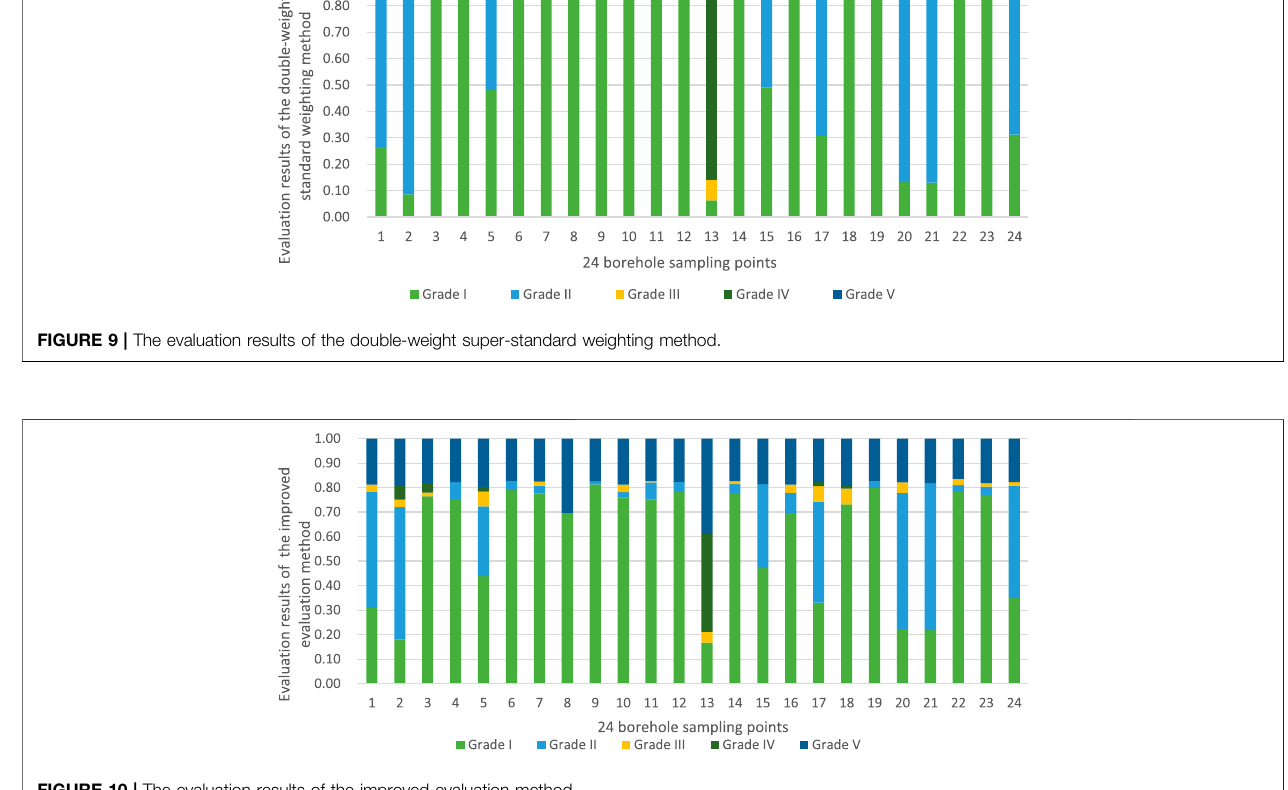
FIGURE 10 | The evaluation results of the improved evaluation